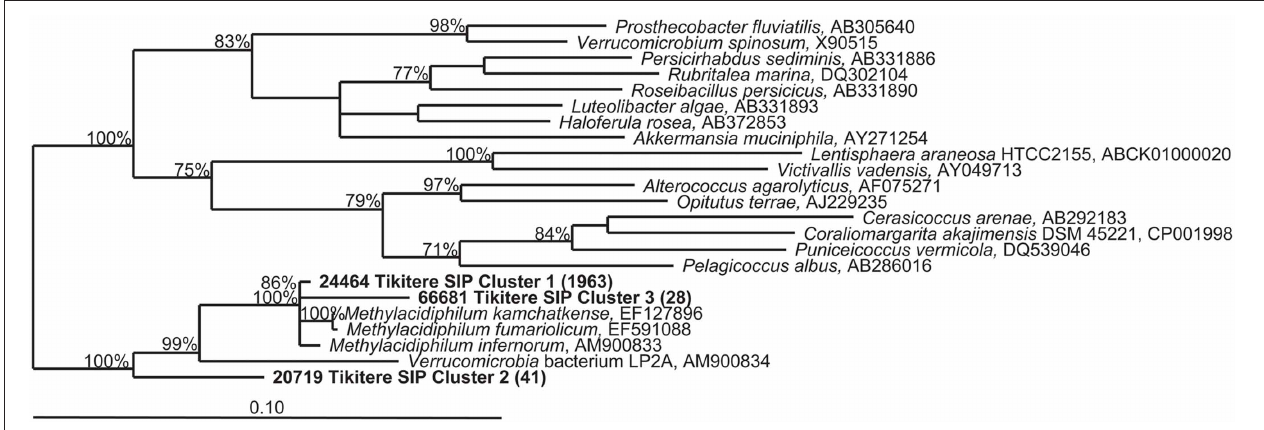
TREE PUZZLE, a quartet maximum-likelihood method, using a Schoeniger-von Hasseler distance calculation (Schmidt et al., 2002) and 10,000 iterations. Support values greater than 70% for the major nodes are given. The scale bar represents 0.1 changes per nucleotide position. Bracketed numbers indicate the number of sequences detected per cluster (from 33,702 total